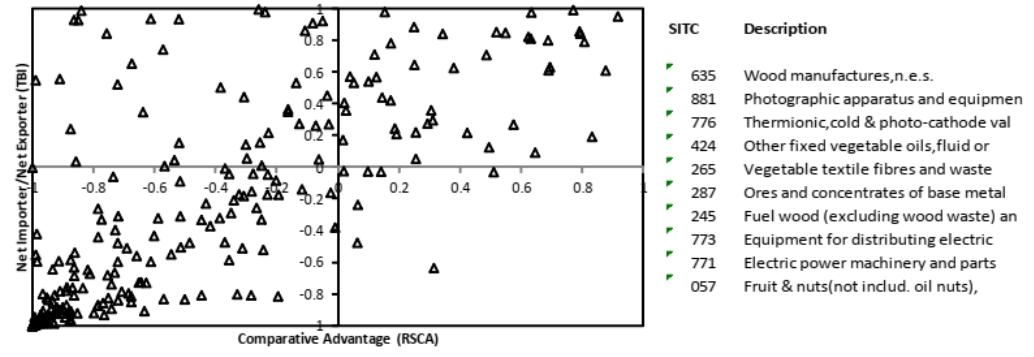
Figure 13: Products Mapping and the Top-Ten Export Products of Philippines, 2014